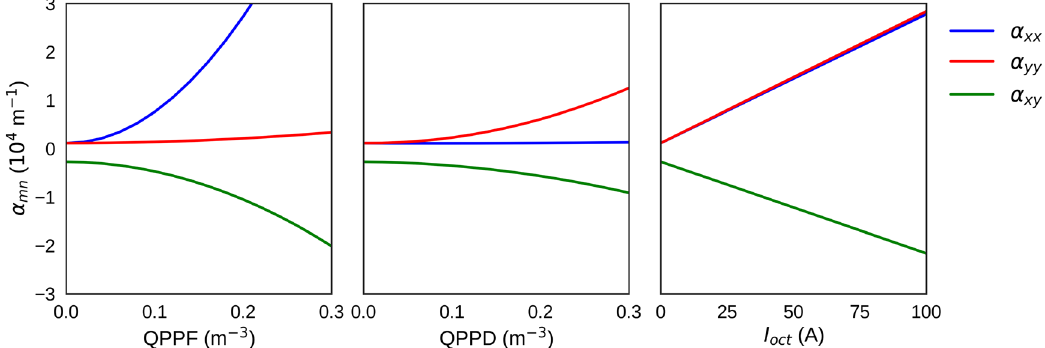
FIG. 3. MAD - X calculation of the transverse amplitude detuning coefficients introduced by the two sextupole knobs QPPF (left) and QPPD (middle) and, for comparison, by the LHC Landau octupoles